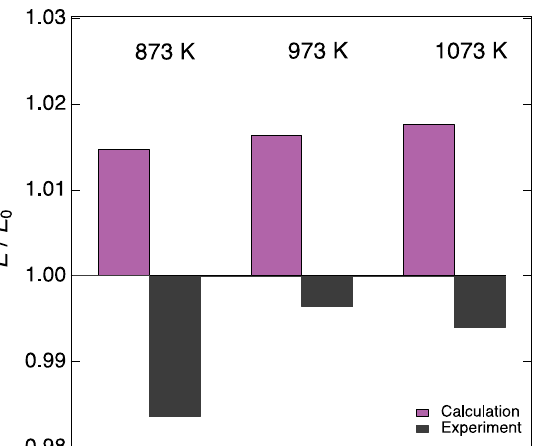
Figure 7. Change in the Young’s modulus due to variation in interstitial oxygen concentration that was calculated using Equations (21) and (22) at 873, 973, and 1073 K (purple bars). These changes were calculated under the assumption that interstitial oxygen concentration of LN214 was changed from the value under a P (O 2 ) of 10 − 4 bar at each temperature ( δ = 0.080, 0.068, and 0.056 at 873, 973, and 1073 K, respectively [24]) to the one under a P (O 2 ) of 10 − 1 bar at each temperature ( δ = 0.107, 0.097, and 0.087 at 873, 973, and 1073 K, respectively [24]), while the a - and c -lattice constants remained unchanged. Black bars represent the experimentally observed change in the Young’s modulus of LN214 when the P (O 2 ) was changed from 10 − 4 to 10 − 1 bar at each